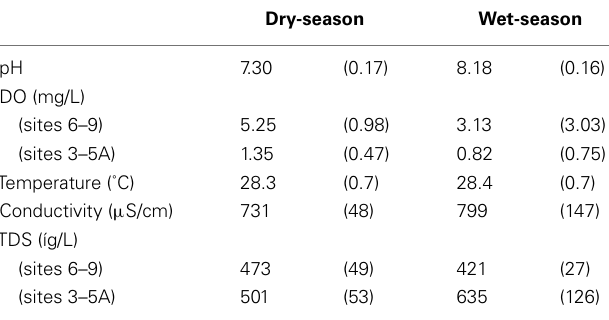
TableA1 | Physico-chemical conditions along theAlmendares River.